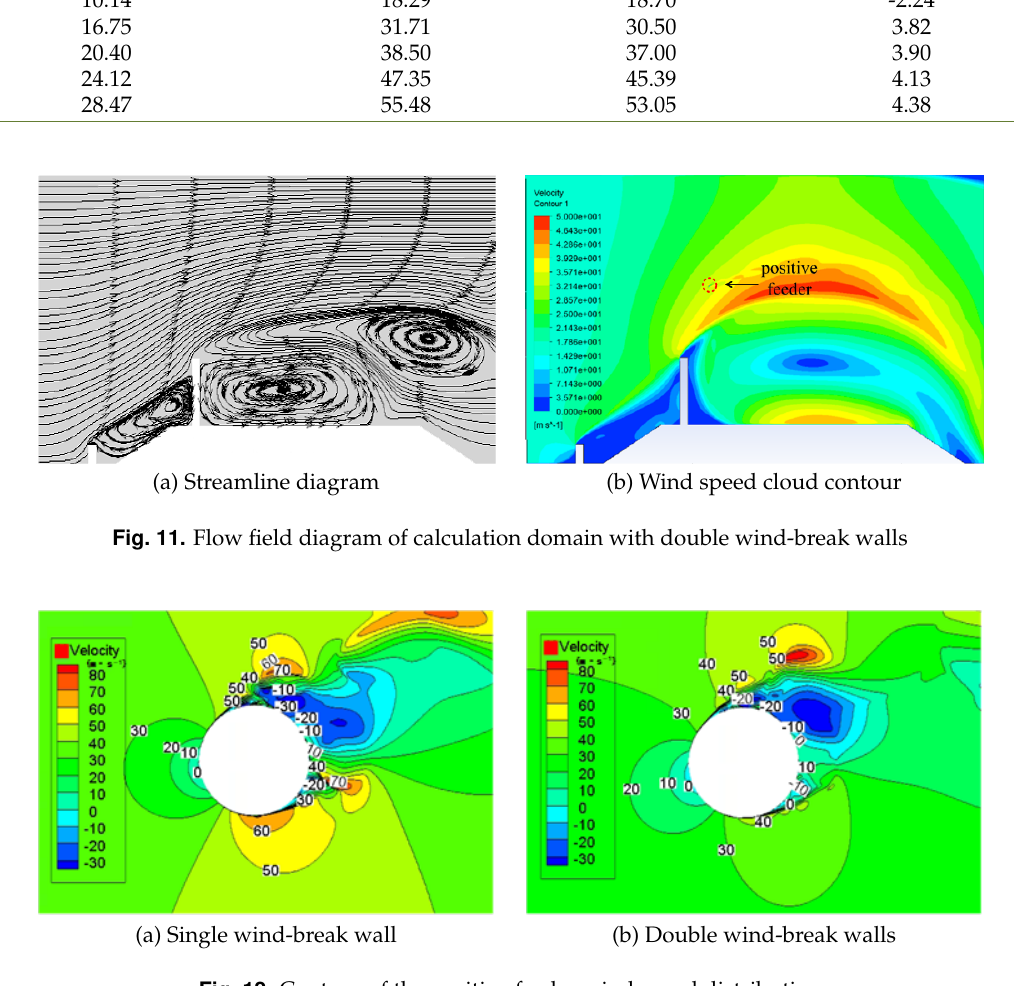
Fig. 12. Contour of the positive feeder wind speed distribution